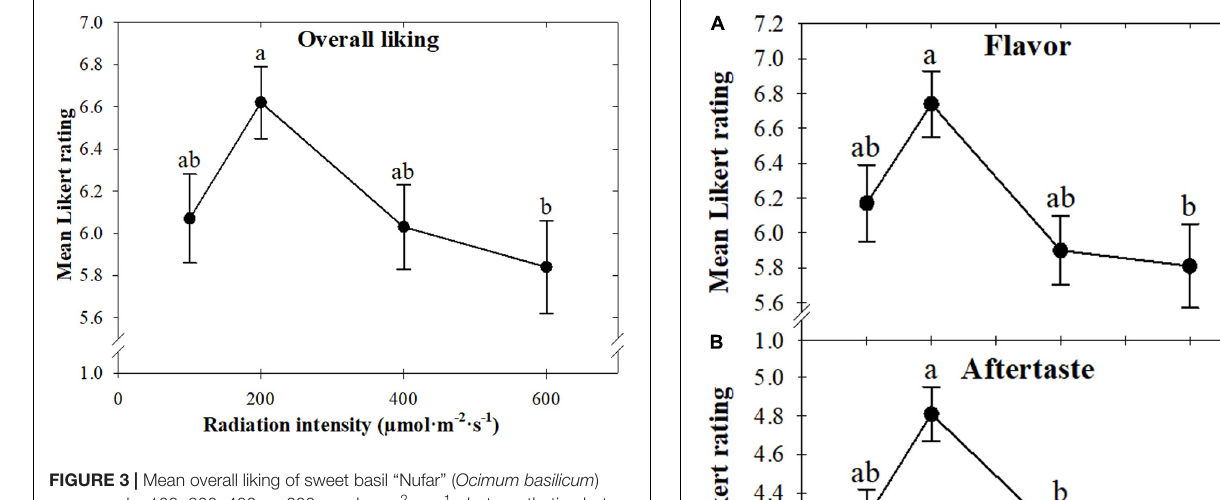
FIGURE 3 | Mean overall liking of sweet basil “Nufar” ( Ocimum basilicum ) grown under 100, 200, 400, or 600 µ mol · m − 2 · s − 1 photosynthetic photon flux density (PPFD), based on a nine-point Likert scale ranging from dislike extremely (1) to like extremely (9). Means not followed by the same letter are significantly different by Tukey honestly significant difference test ( P < 0.05). Each symbol represents 90 responses ± SD.